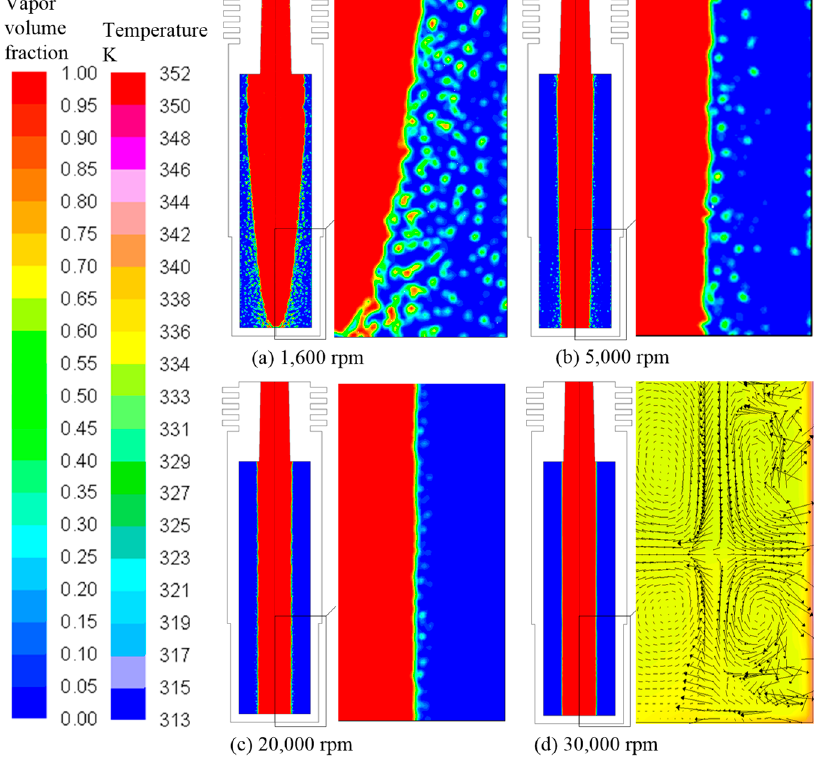
Figure 8. Heat transfer mechanism under different rotational speeds.